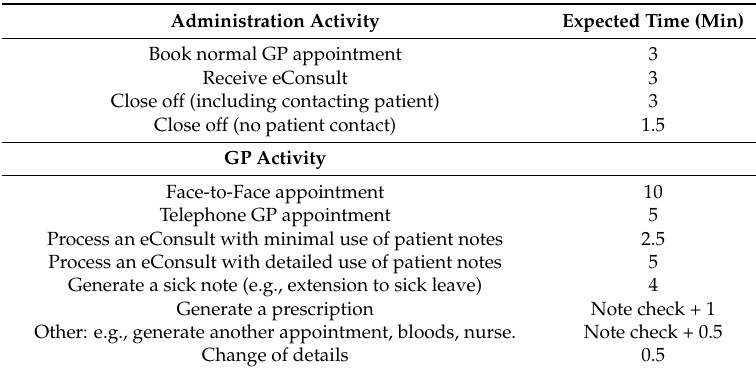
Table 2. Estimated timings for eConsult related